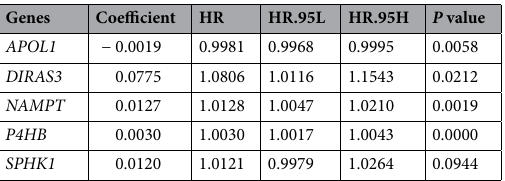
Table 1. Construction of five PDEARGs-based prognostic risk model. HR hazard ratio, HR.95H and HR.95L 95% confidence